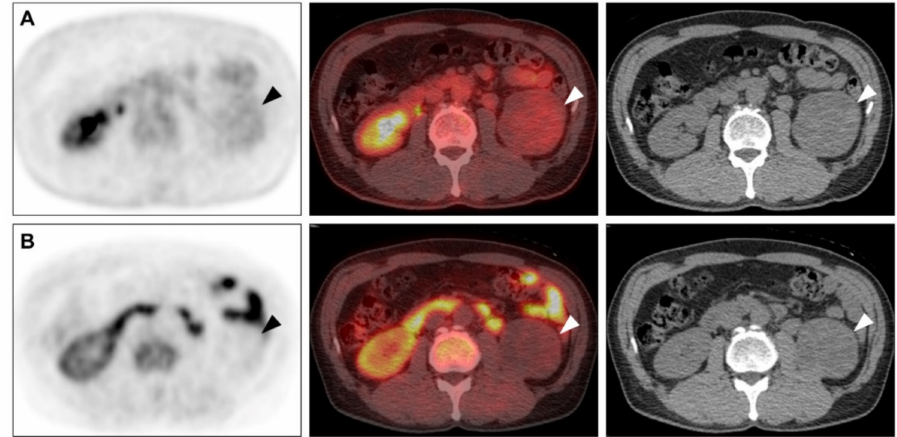
Figure 1. RCC with low MTV. A 56-year-old male had a renal mass (arrowhead) with low F-18 FDG uptake (( A ) SUV max : 2.16, MTV: 0.0 cm 3 ) and low C-11 MET uptake (( B ) SUV max : 1.49, MTV: 1.38 cm 3 ). A 7.7-cm-sized Fuhrman grade 2 clear cell carcinoma was reported after surgery.